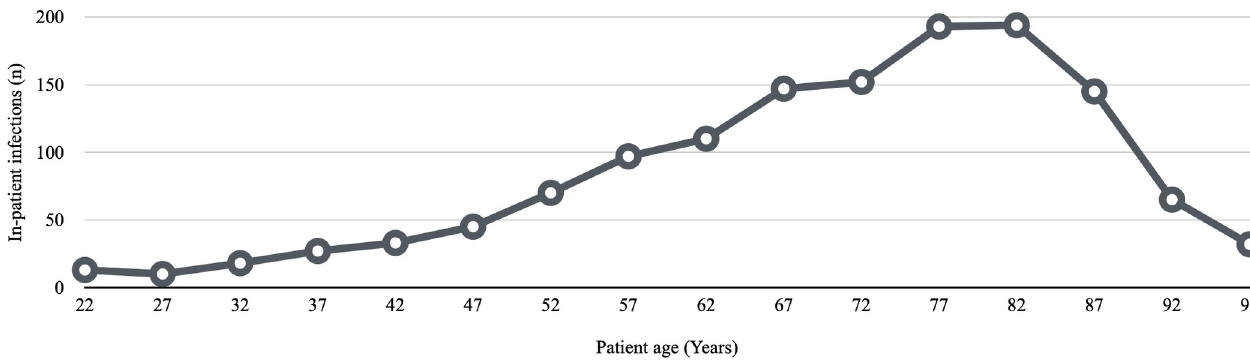
Fig 2. Age distribution of inpatient infections.